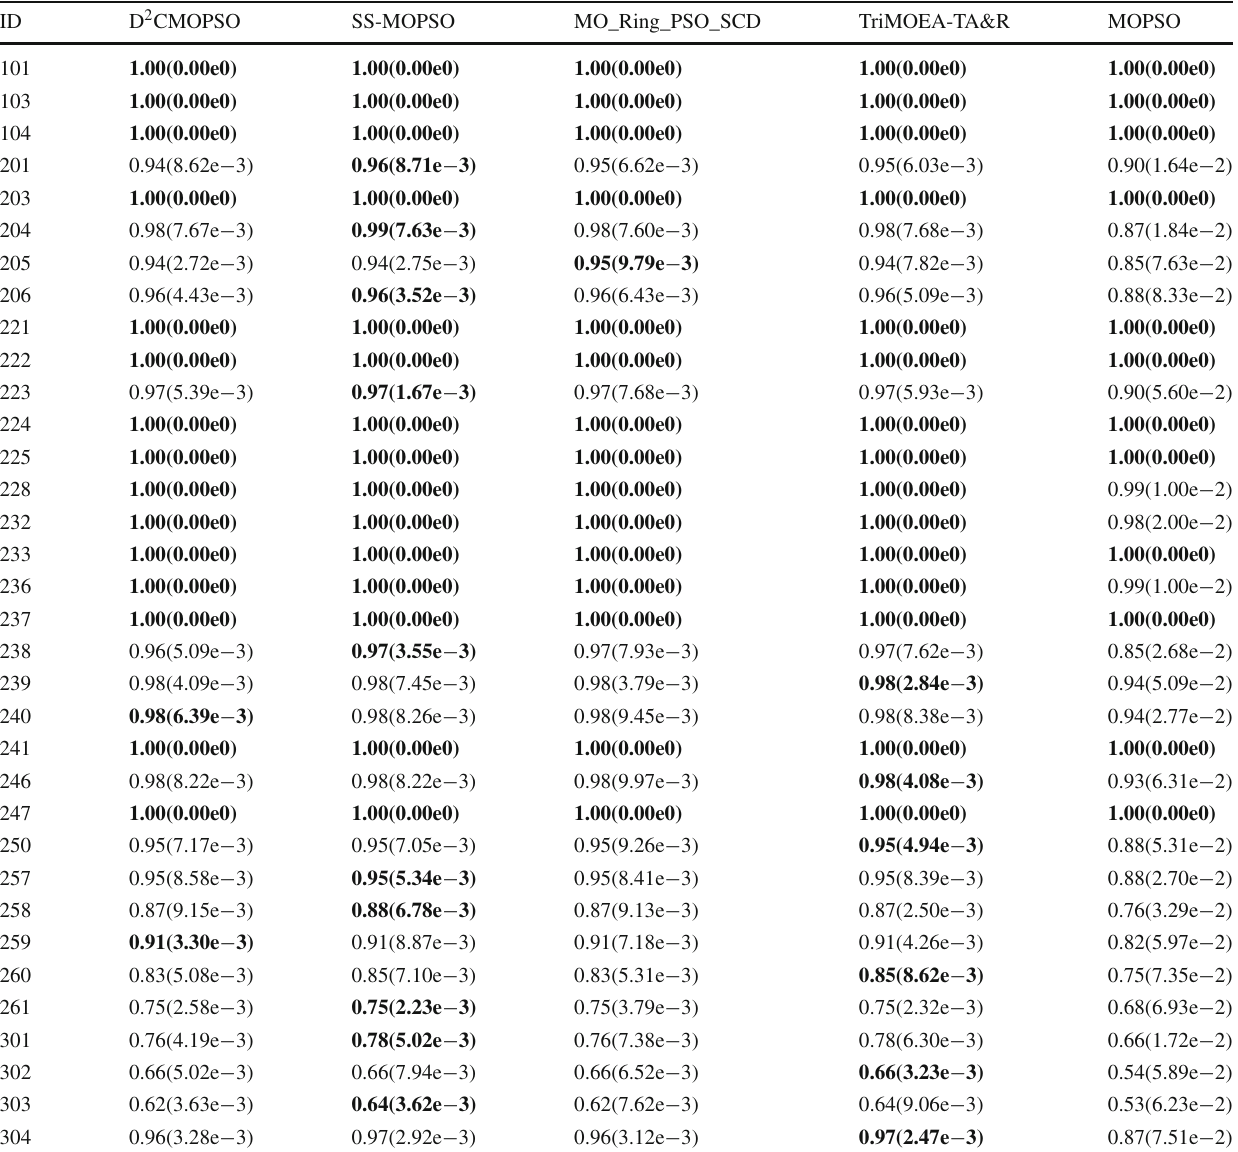
Table 14 HV values of other related algorithms-based matching systems in benchmark